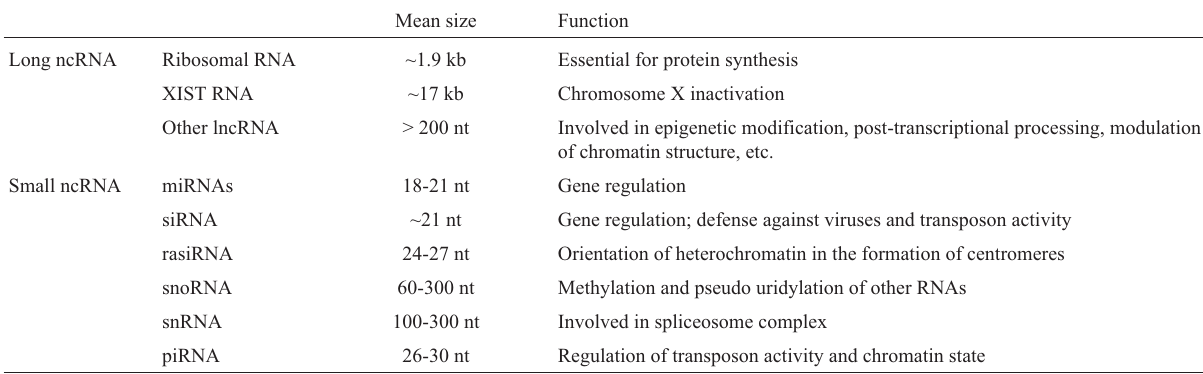
Table 1 - Different types, main characteristics and functions of non-coding